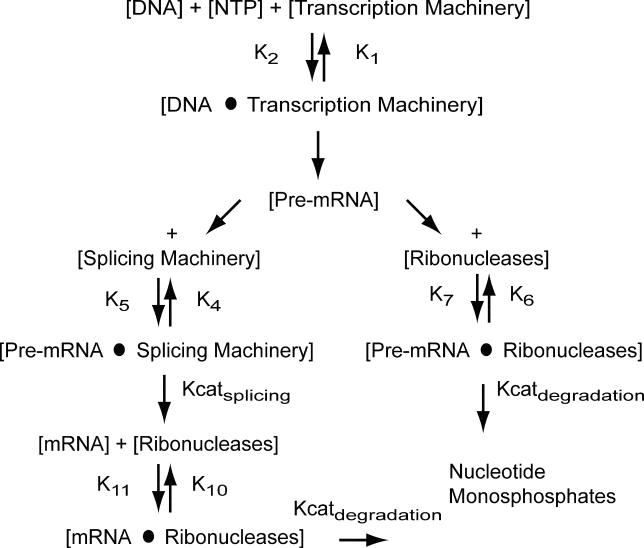
Minimal Kinetic Scheme of the In Vitro Reaction Linking Pol II Transcription with Pre-mRNA SplicingThe diagram shows a series of dissociation and association constants for the formation of complexes between the DNA template and the transcription machinery, between the pre-mRNA and ribonucleases or the splicing machinery, and between the spliced mRNA and ribonucleases. The catalytic rate constants describe the conversion of NTPs to pre-mRNA for transcription, the conversion of pre-mRNA to mRNA for splicing, and the conversion of pre-mRNA or mRNA to nucleotide monophosphate for ribonuclease digestion.